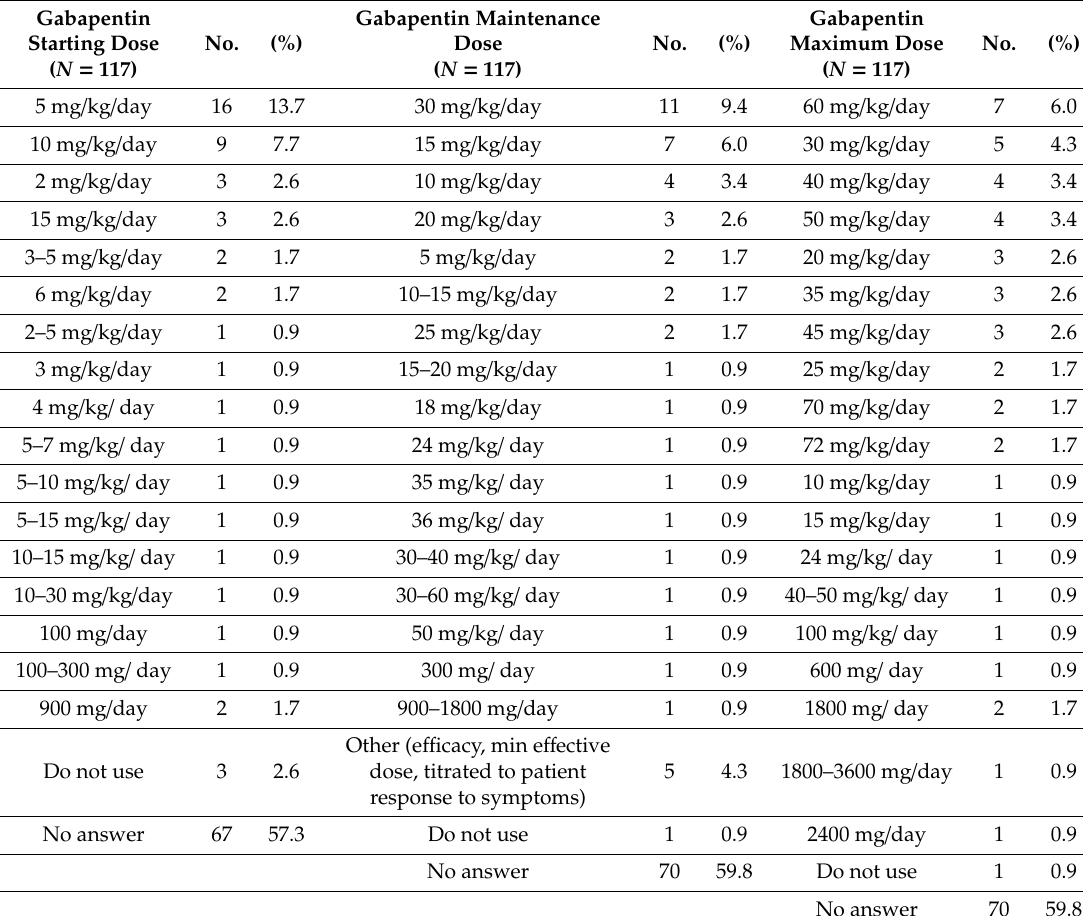
Table 8. Gabapentin titration dosages used by practitioners.